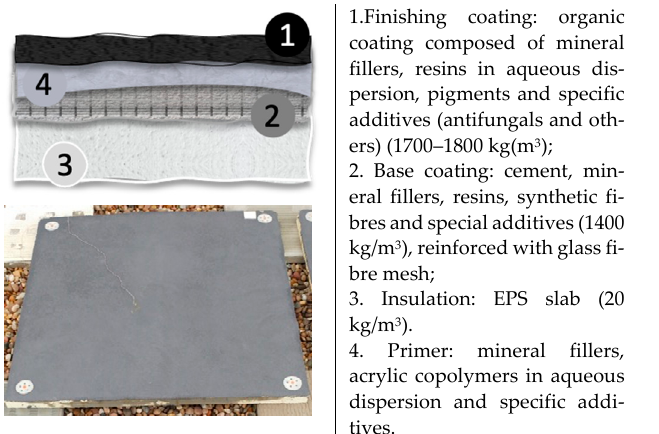
Figure 2. Constitution of the specimens and placement “in situ” (only specimens with primer have layer 4).